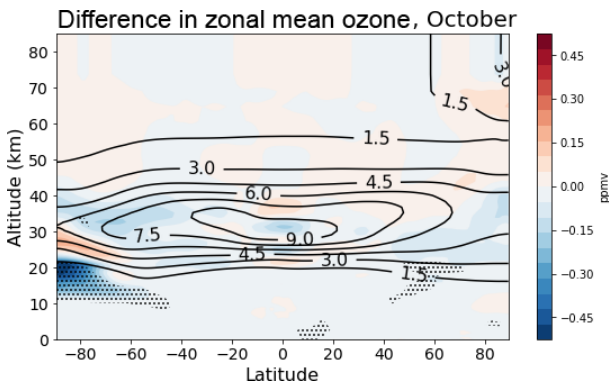
Figure 8. Difference in zonal mean ozone between the “new het.” and control runs during October 1996–2009 (shading). Contours il- lustrate the control run climatology. Stippling indicates the differ- ence is significant according to Student’s t test ( p < 0 . 01).